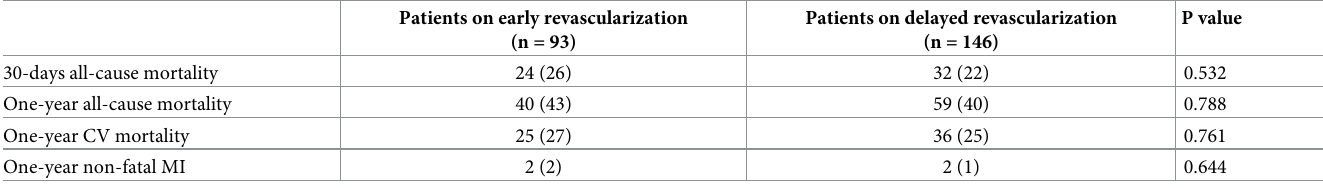
Table 3. Outcomes of patients with early and delayed